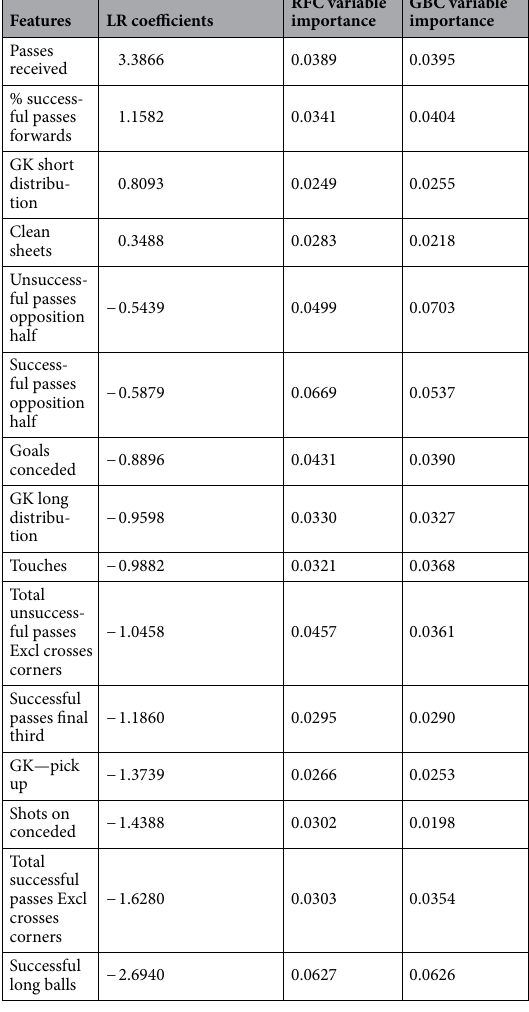
Table 4. Feature importance from multiple machine learning